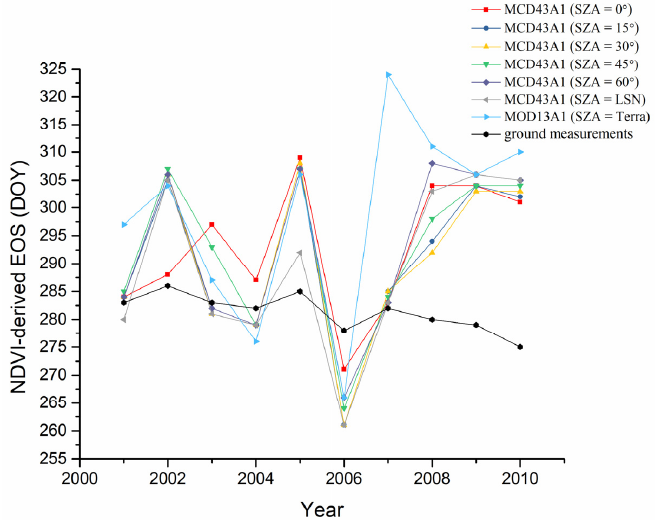
Figure 6. EOS derived from the NDVI time series from 2001 to 2010. SZA = 0°, 15°, 30°, 45° and 60° denote the EOSs derived from the MCD43A1 (BRDF) product with a consistent angle configuration; SZA = LSN and SZA = Terra refer to EOSs derived from the MCD43A4 (NBAR) product and the MOD13A1 (VI) product, respectively.